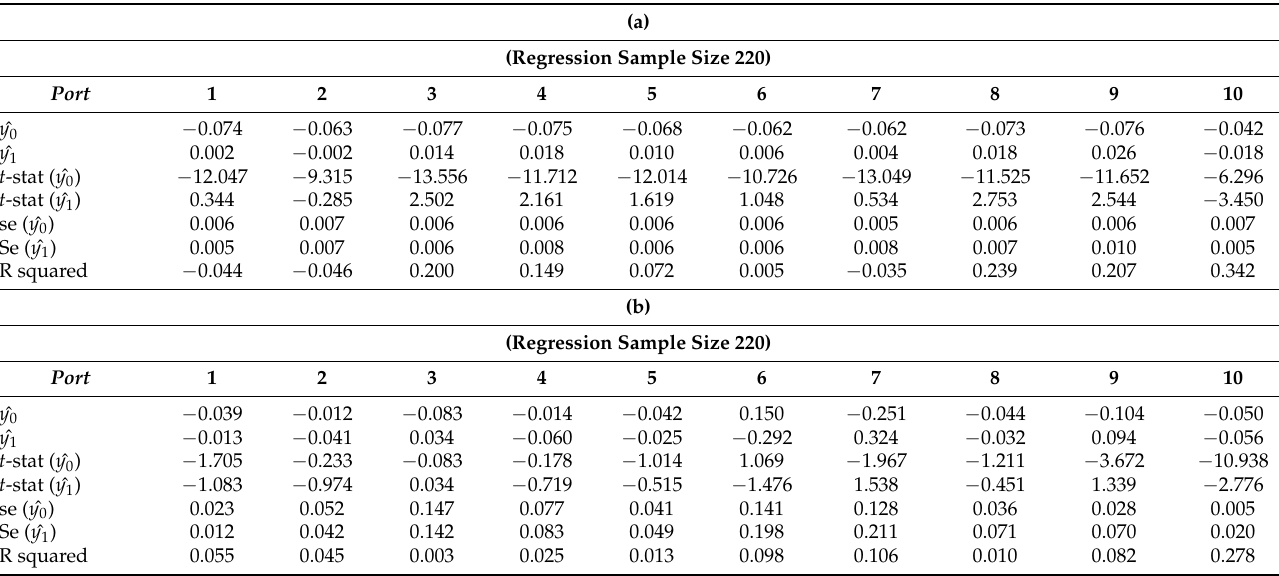
Table 4. ( a ) Results for cross-sectional second-pass regression (weighted portfolios) (May 2016 to June 2021); ( b ) results for cross-sectional second-pass regression (beta portfolios) (May 2016 to June 2021). (a) (Regression Sample Size